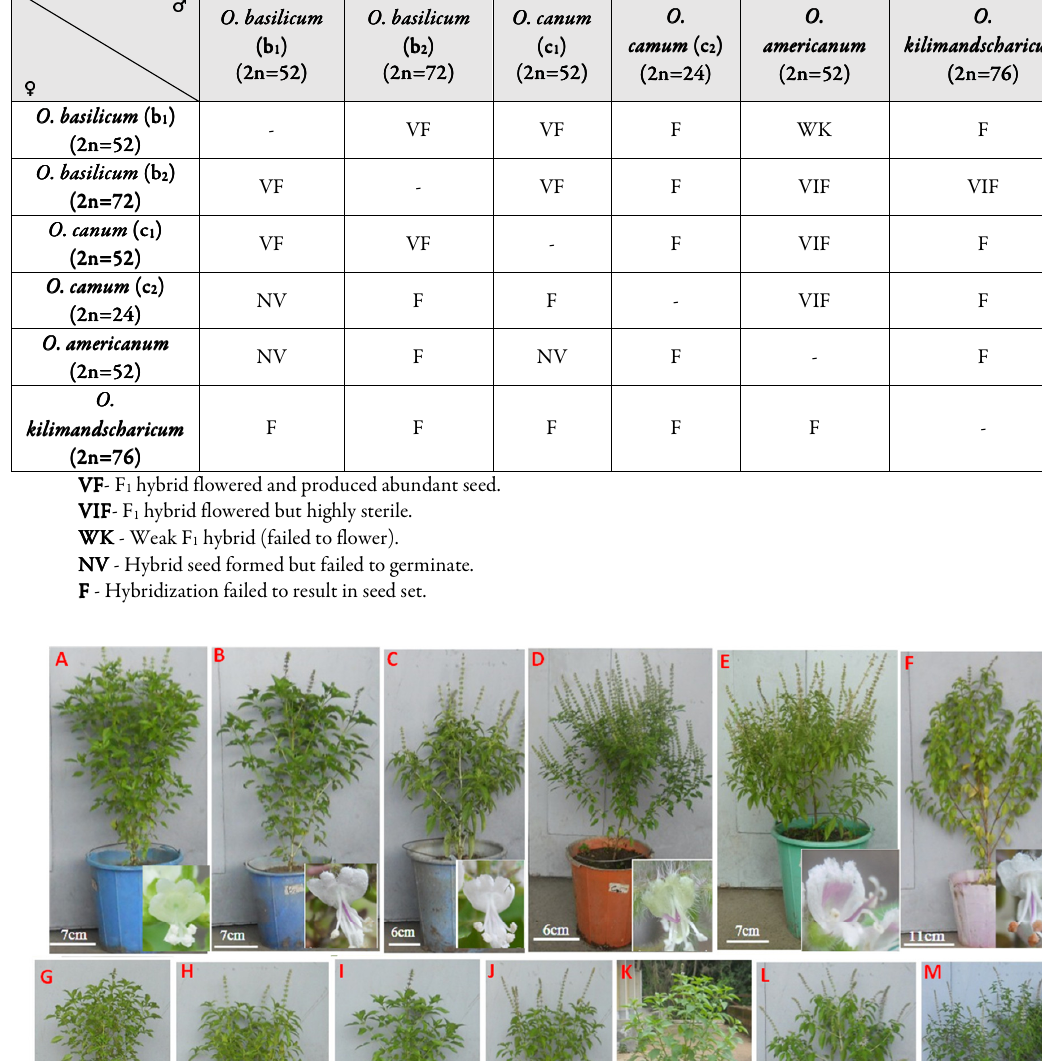
Table 1. Summary of reciprocal intraspecific and interspecific crosses among the Ocimum species studied